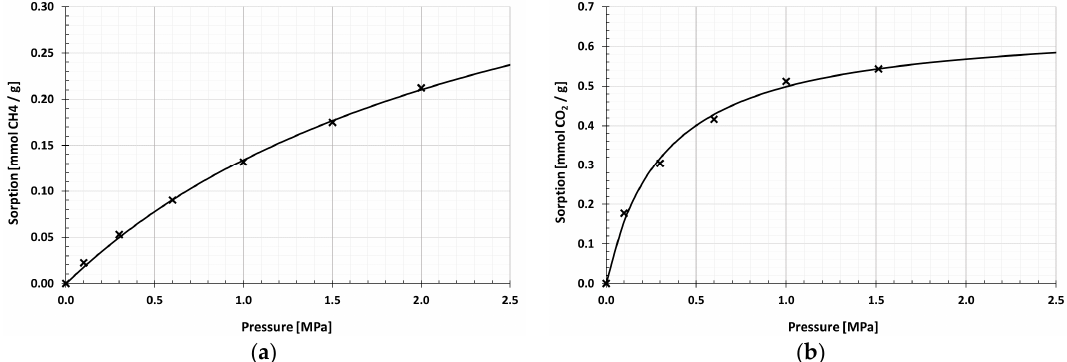
Figure 9. Sorption isotherms of raw halloysite: ( a ) CH 4 sorption isotherm; ( b ) CO 2 sorption isotherm.